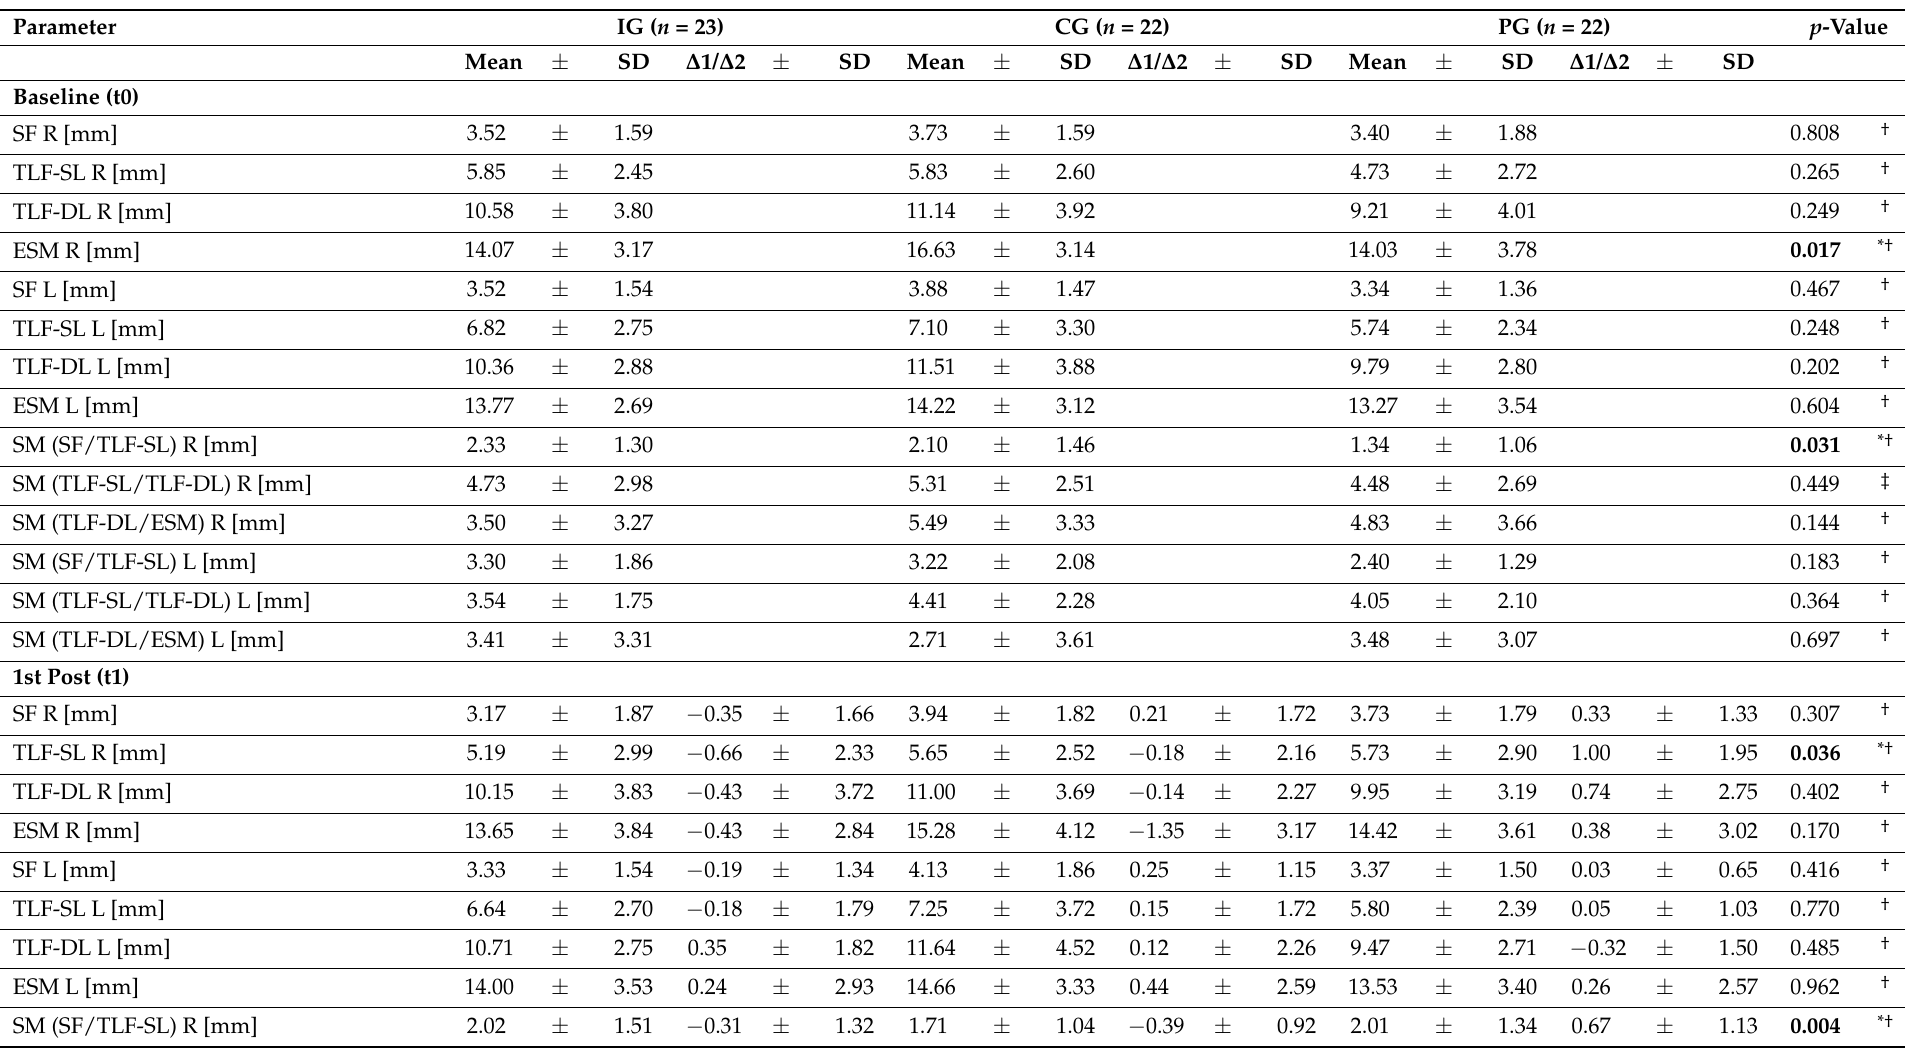
Table 2. Structural Movement